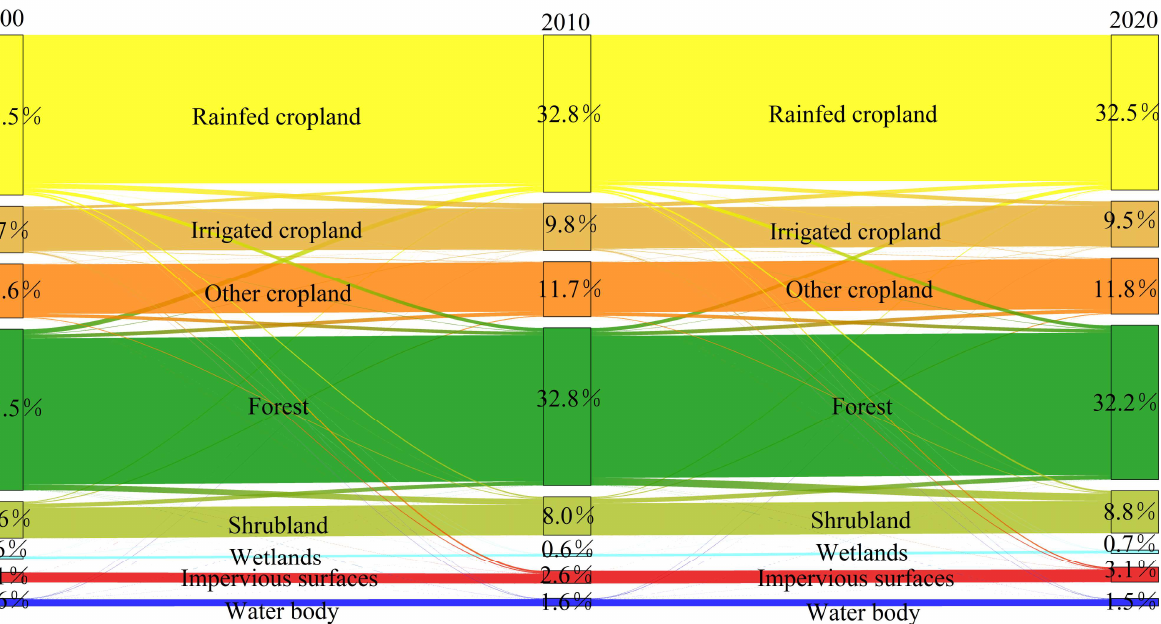
Figure 4. Land use/cover transfer plot of Thailand during 2000–2020.